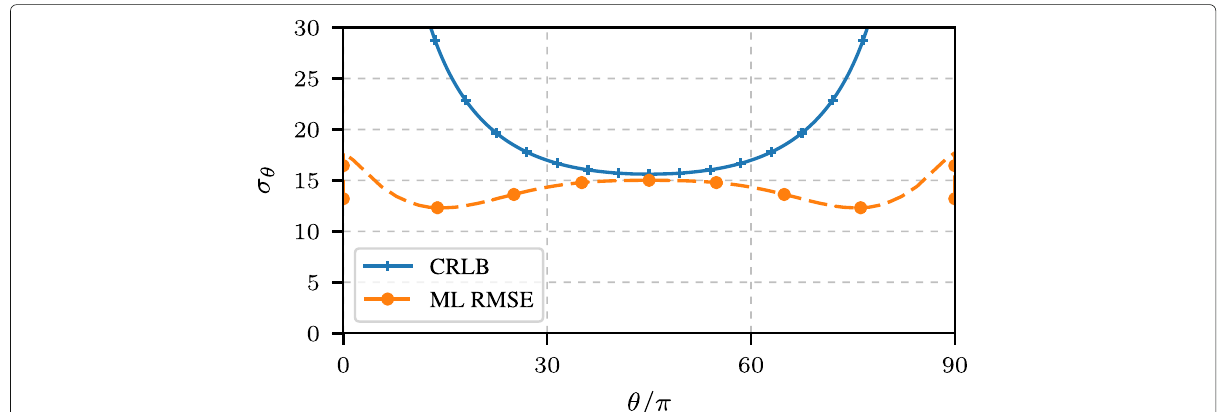
Fig. 7 CRLB compared to ML RMSE. With the ML estimator, the RMSE is significantly reduced compared to the MVUE at the cost of being